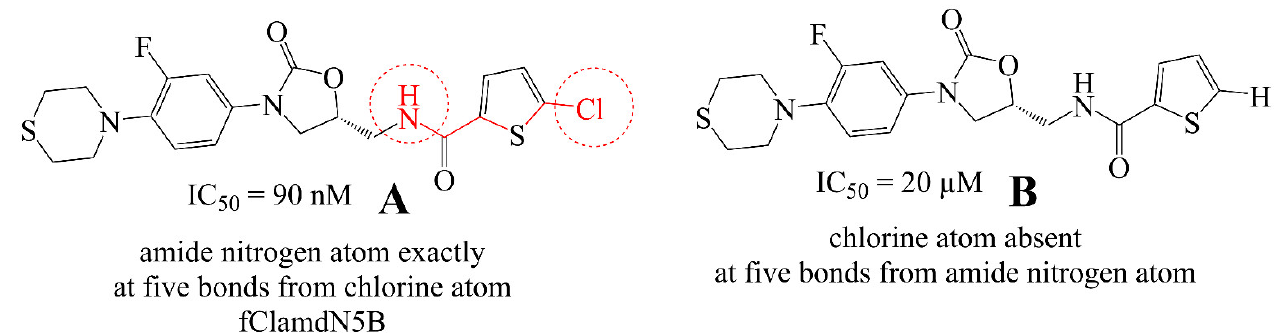
Figure 5. Representative examples molecule ( A ) and ( B ) to understand fClamdN5B (highlighted by red colored bonds and atoms) .